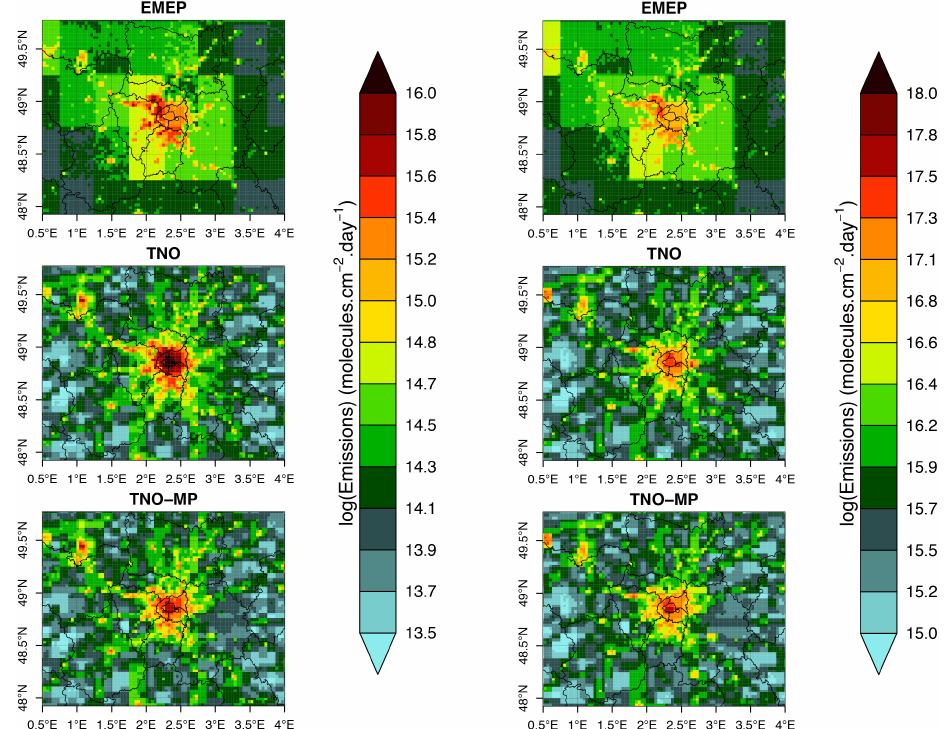
Figure 1. BC (left panels) and NO x (right panels) emissions in EMEP, TNO and TNO-MP